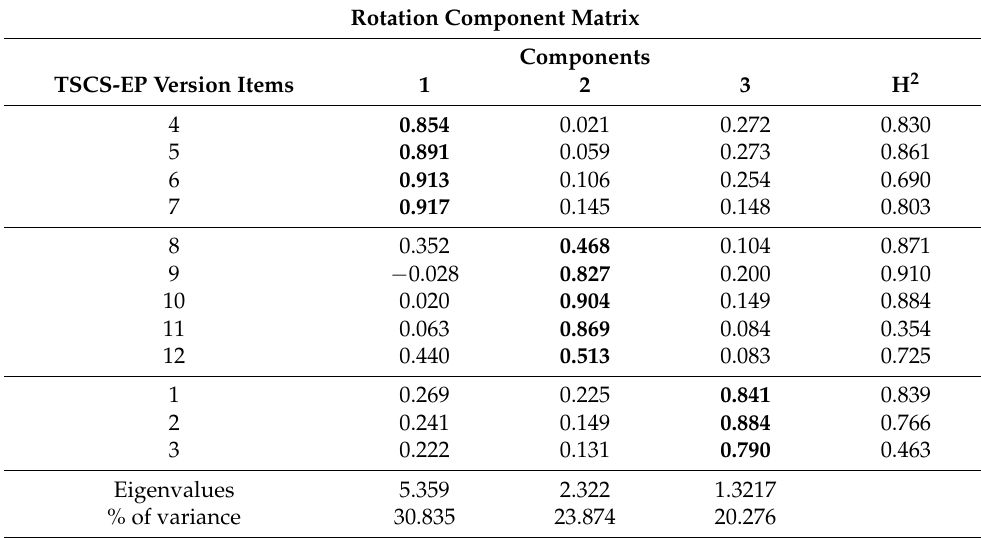
Table 2. Principal components matrix after orthogonal varimax rotation of items and